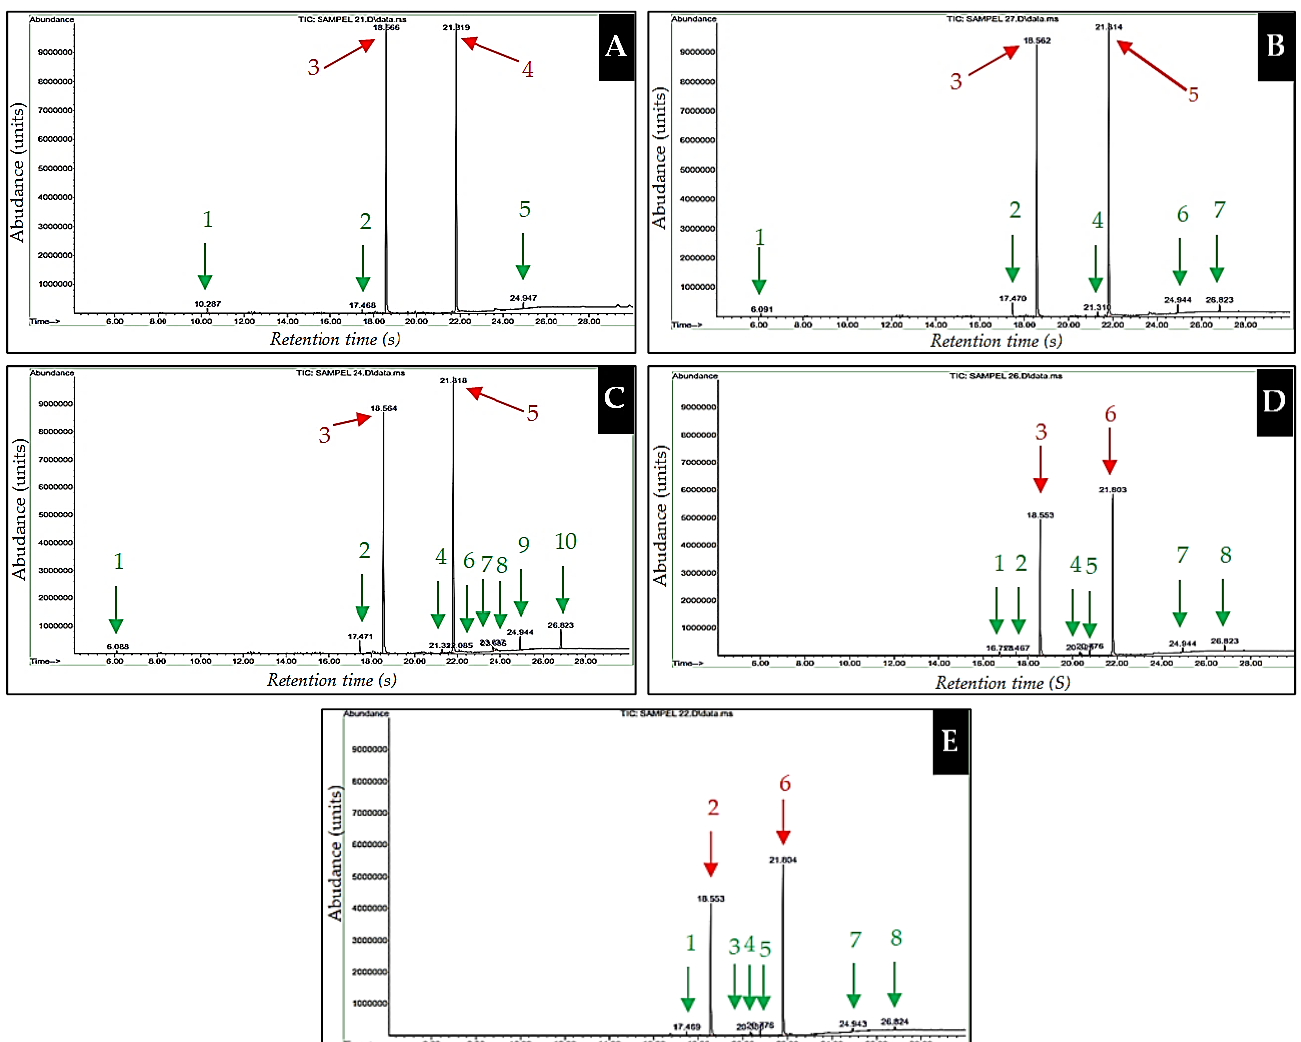
Figure 4. GC–MS spectrum showing the biodegradation performance of the marine sponge consortium bacterial suspension in terms of the abundance of anthracene and pyrene components and new peaks related to biodegradation products as a function of interaction time: peak abundance after ( A ) 5 days of interaction, ( B ) 10 days of interaction, ( C ) 15 days of interaction, ( D ) 20 days of interaction, and ( E ) 25 days of